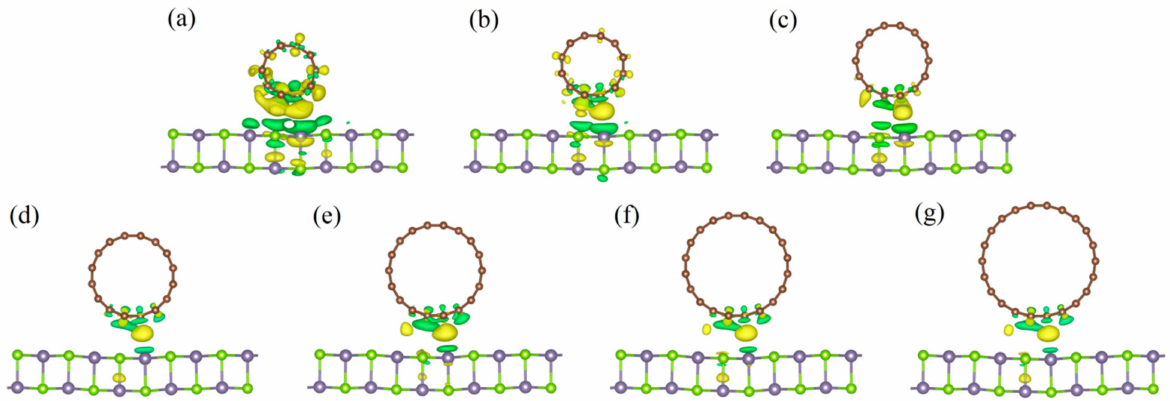
Figure 3. Charge density differences for CNT( n ,0)/GeSe with n = ( a ) 5, ( b ) 6, ( c ) 7, ( d ) 8, ( e ) 9, ( f ) 10, and ( g ) 11. The isovalue is set to 0.0015 e /Å 3 . The yellow and green regions represent charge loss and gain of electrons,